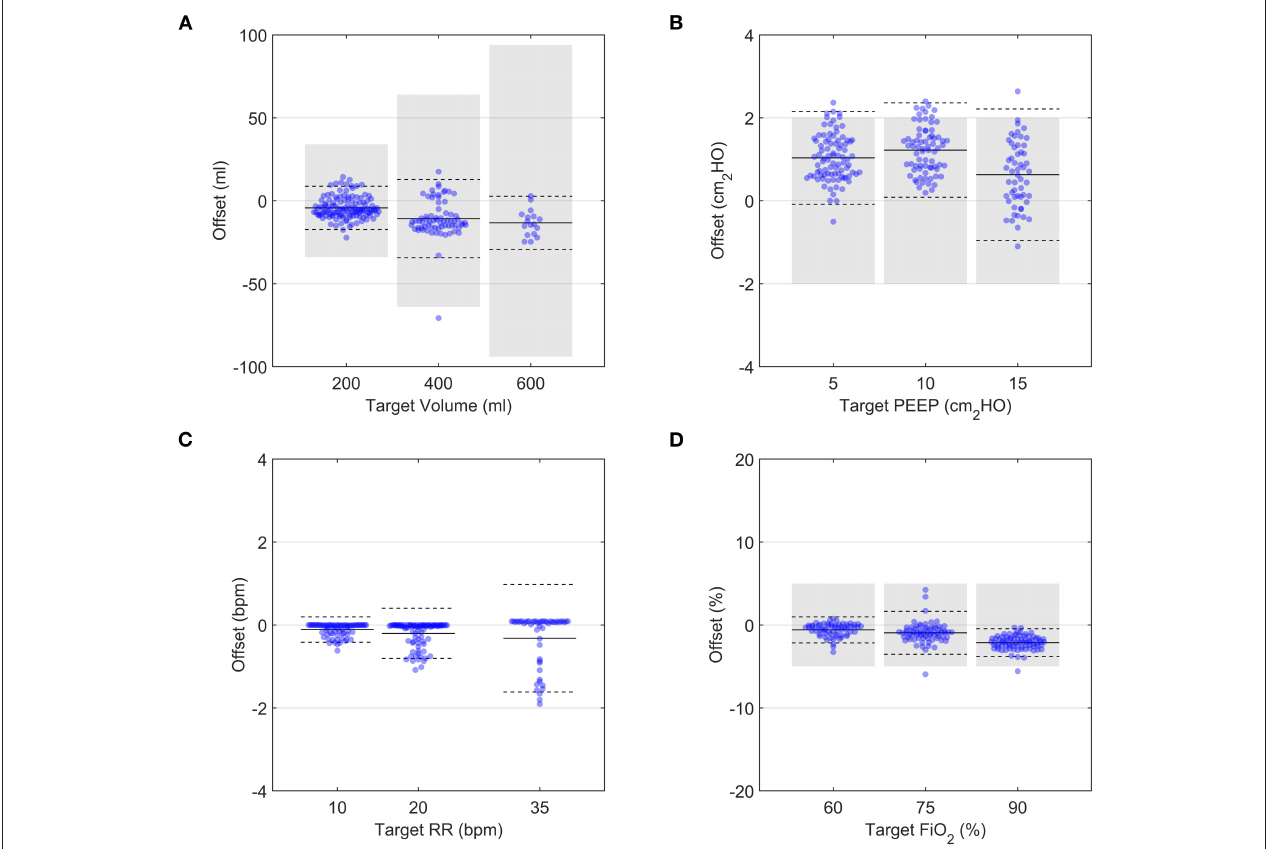
FIGURE 6 | Demonstration of the performance over a range of setting permutations for an R20/C20 test lung configuration. Each data point represents the average of 9 breaths taken 5 breaths after a change in a single clinical input was implemented. In all panels, solid black lines and dashed black lines represent the average and 2 SD of all datapoints at a given target value, respectively. Grey shaded regions indicate ISO 80601-2-12:2020 measurement uncertainties. (A) Tidal volume, (B) PEEP, (C) Respiratory Rate, (D) FiO 2